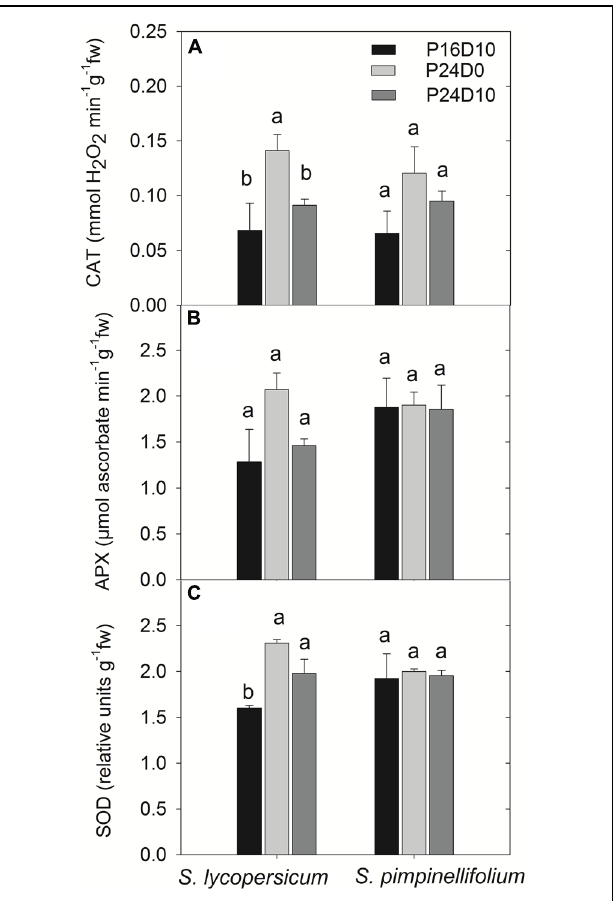
FIGURE 5 | Catalase (CAT, A), Ascorbate peroxidase (APX, B), and Superoxide dismutase (SOD, C) enzymes activities in the plants of S. lycopersicum and S. pimpinellifolium at different days in P16D10, P24D0, and P24D10 growth conditions. The data were taken at the end of the light period on day 12 (12:30 CEST). Vertical bars are SEM ( n = 4). Treatment means with different letters within each species are significantly different and the statistical analysis was done by the Tukey and Waller–Duncan k-ratio t